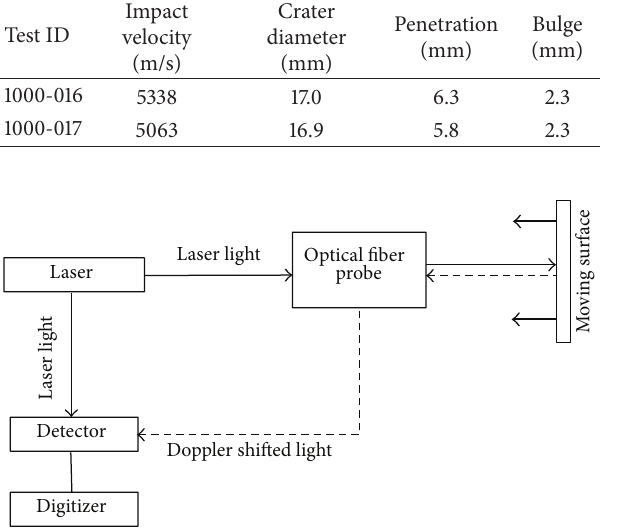
Figure 3: Basic principle of a single channel PDV system (based on